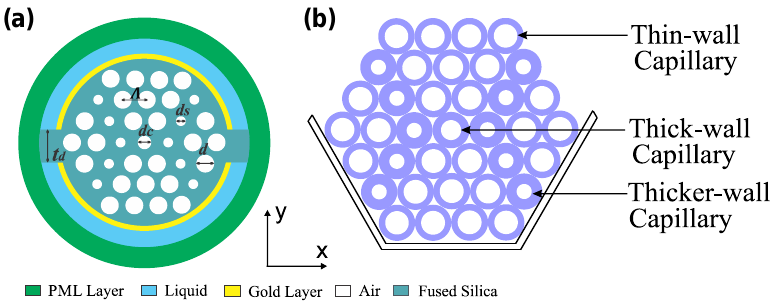
Figure 1. ( a ) 2D cross-sectional view of the proposed sensor, and ( b ) stack preform. In the design, two channels with uniform thickness ( t a ) were adopted to hold the analytes. Here the upper channel is defined as channel-1 (Ch-1) and the lower channel is defined as channel-2 (Ch-2). The reliable gap between two channels is denoted as t d for avoiding the overlap of light coupling. In both channels, noble metal gold (thickness, t ) was coated internally to create SPR effects. The analyte channels were placed at the outer surface of the PCF to make the cleansing and filling process easier, which is the